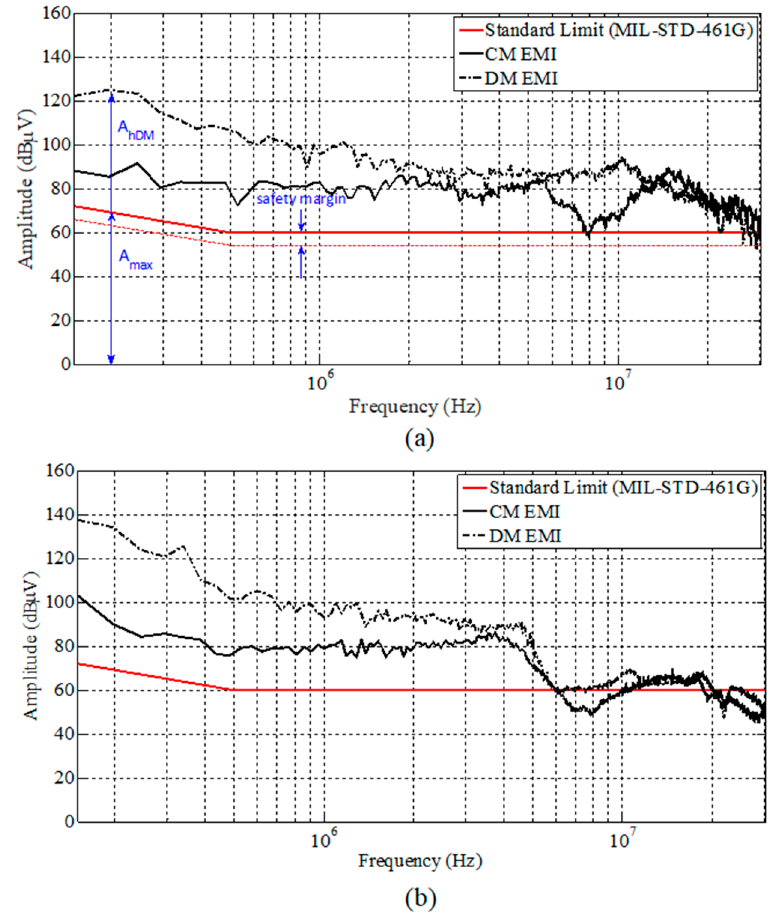
Figure 4. Measured CM and DM EMI for ( a ) three phase induction motor load ( b ) three phase resistive load. In ( a ) the parameters reported in Equations (1) and (2) are also shown.